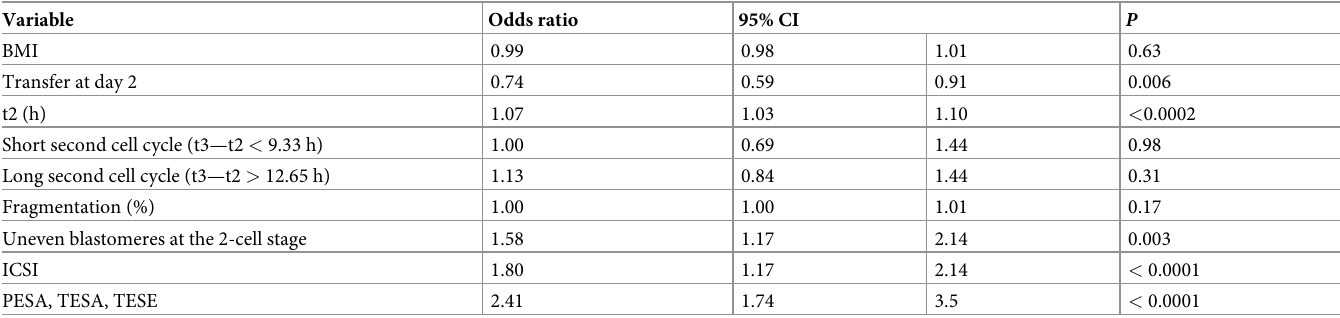
Table 2. Multivariate GAMM analysis for nucleation